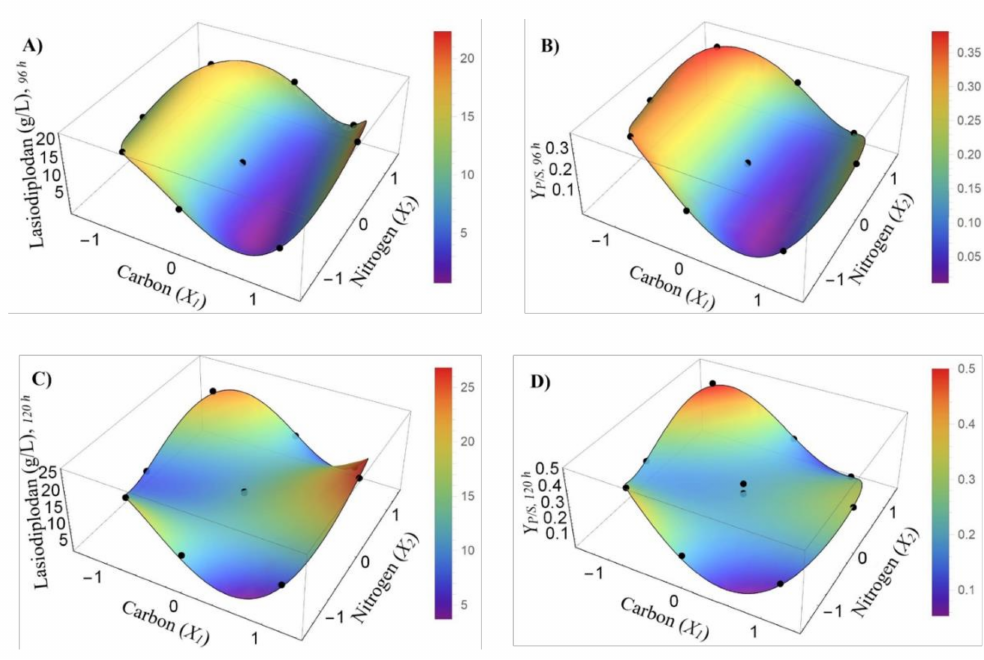
Figure 3. SCBCH and RBE interaction for lasiodiplodan production: ( A ) Production at 96 h; ( B ) Yield at 96 h; ( C ) Production at 120 h; ( D ) Yield at 120 h.